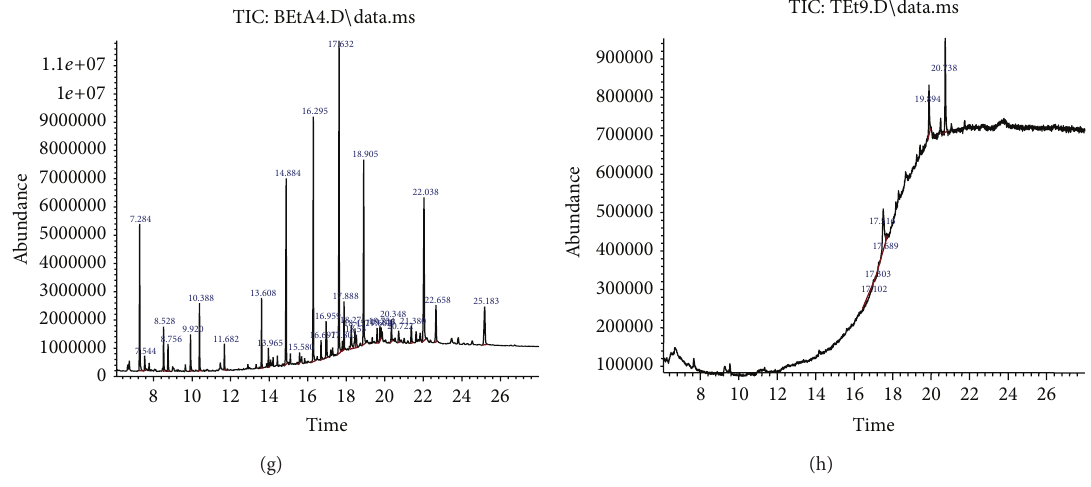
Figure 1: GC-MS total ion chromatogram (TIC) showing the retention time of the compounds identified from the